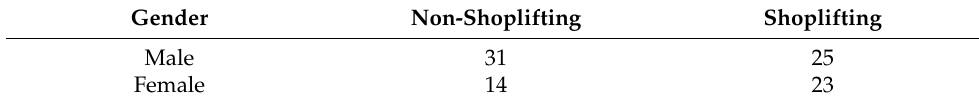
Table 1. Frequency of the gender of the individual within the dataset. Gender Non-Shoplifting Shoplifting Male